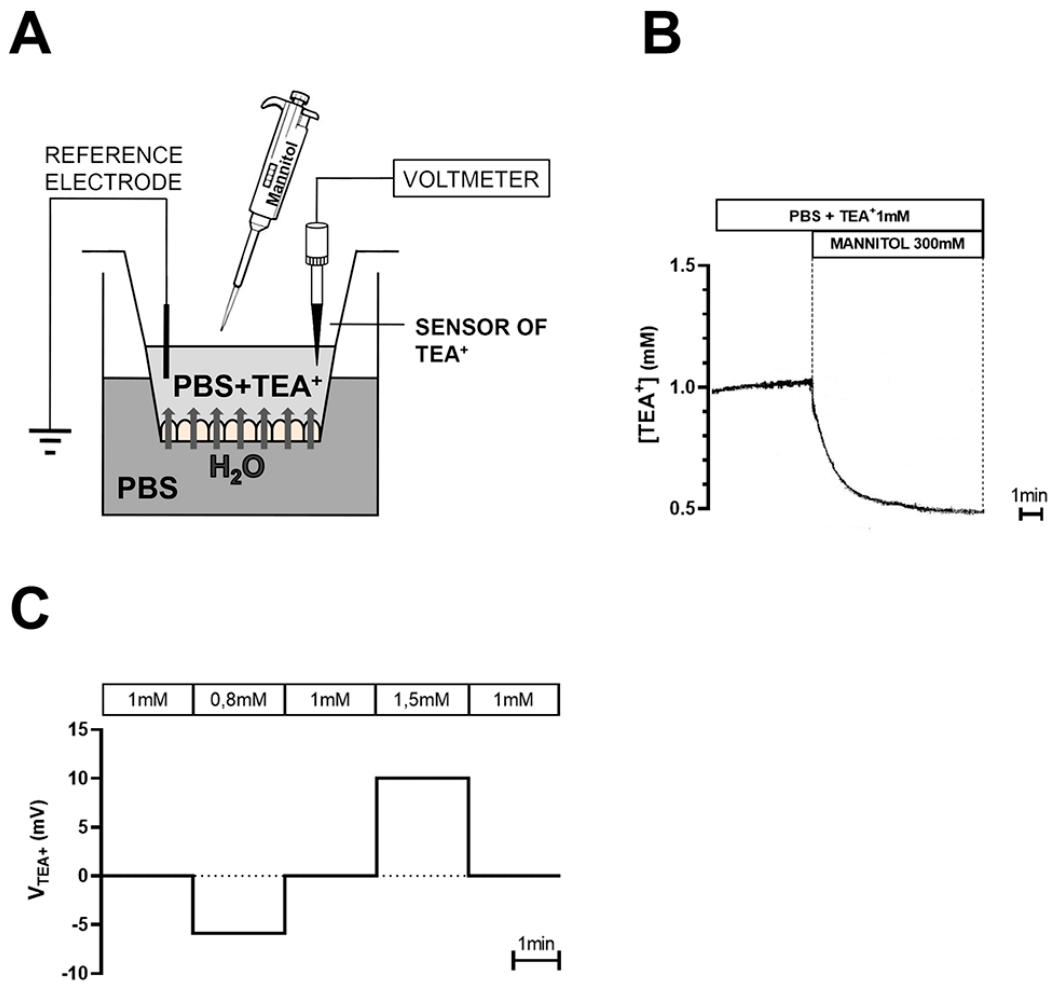
Figure 6. Protocol for transepithelial water transport measurements in HMC monolayers with TEA + -sensitive microelectrodes. ( A ) Schematic representation of set-up used to measure the osmotically induced transcellular water flux across HMC monolayers with TEA + -sensitive microelectrodes positioned in the apical compartment; ( B ) Addition of 300 mM mannitol in the apical chamber triggered a transepithelial water flux from the basolateral chamber that decreased [TEA + ] recorded by the TEA + -sensitive microelectrode in a renal cell monolayer; ( C ) Calibration of TEA + -sensitive microelectrodes by exposure to PBS solutions containing different [TEA + ].